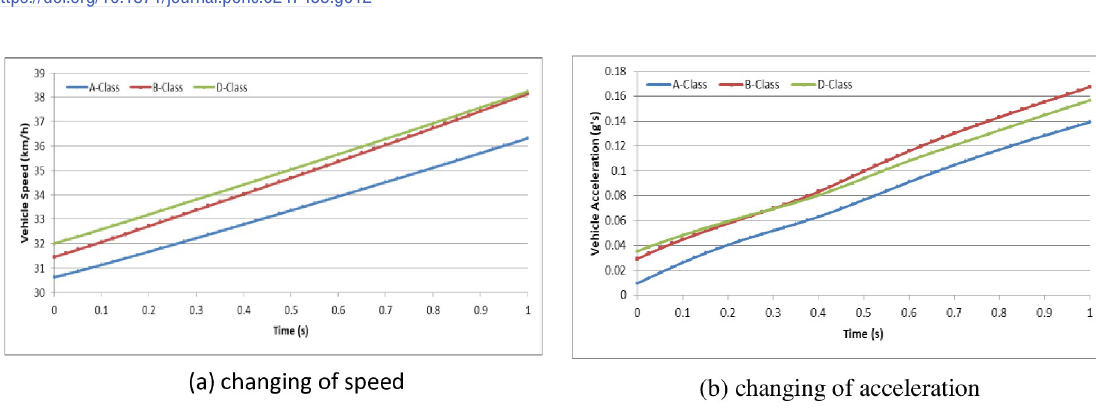
Fig 13. The changes in vehicle speed and acceleration during the reactions at initial speed = 30 km/h with different vehicle models (Group 2).